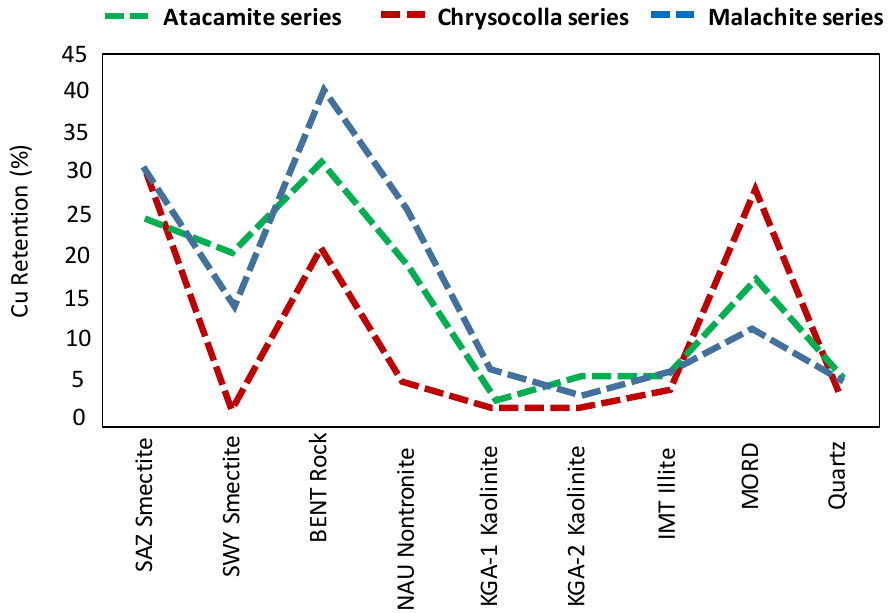
Figure 5. Copper retention (Wt%) in gangues of the malachite, atacamite, and chrysocolla series (Modified from [52]).